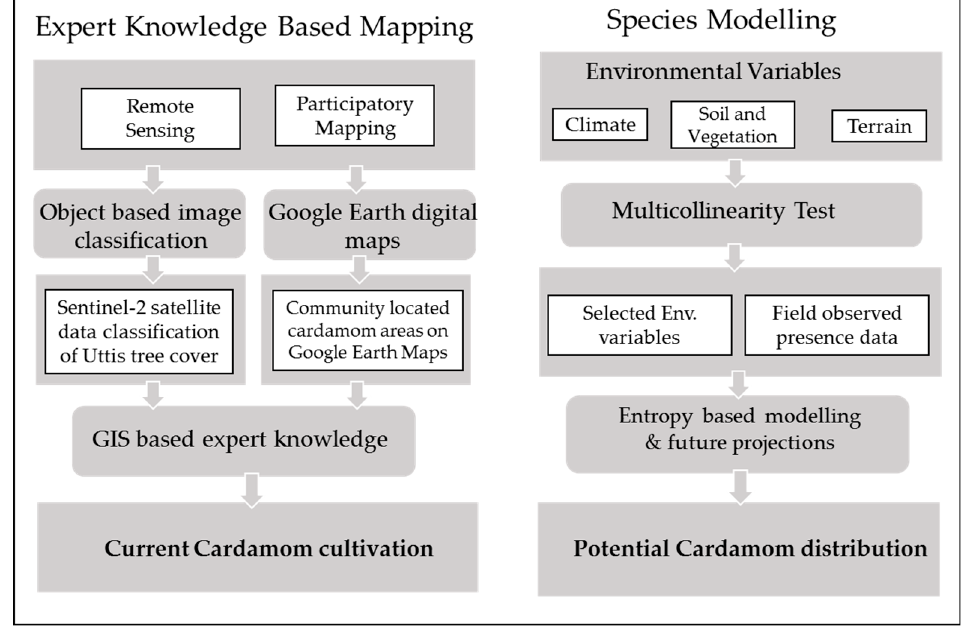
Figure 1. Methodology flow diagram.